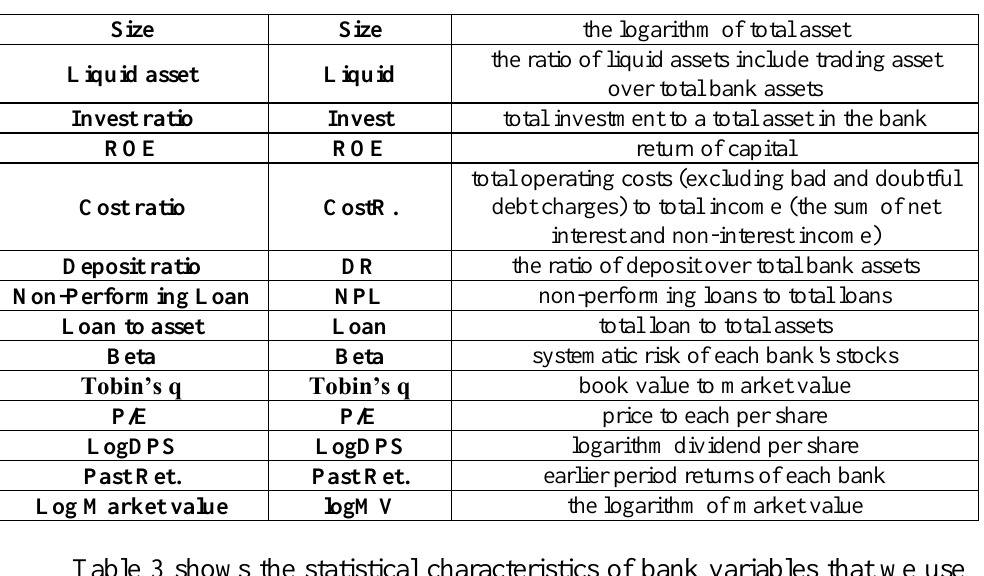
Table 2. Defining Model Variables